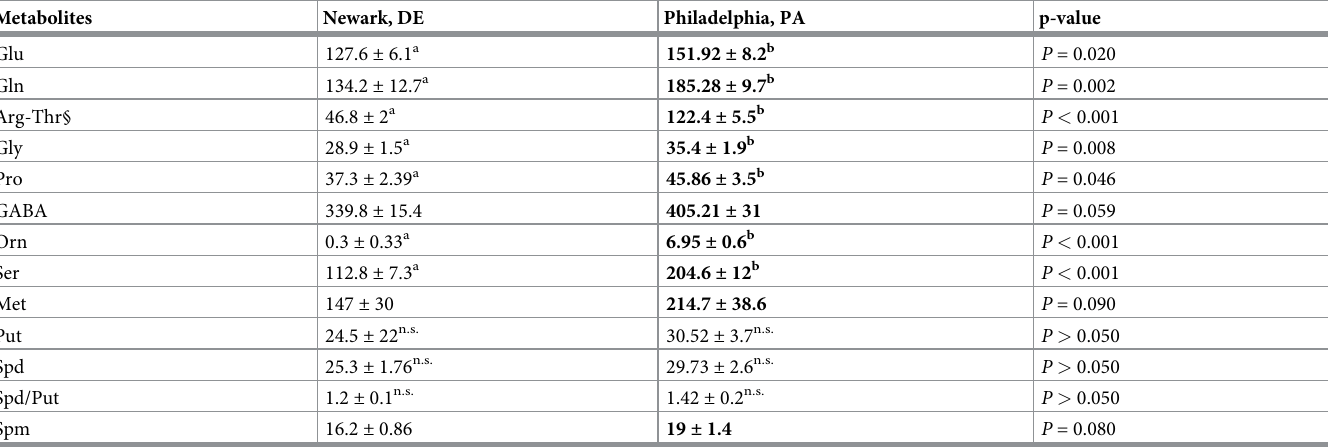
Table 5. Free amino acid and polyamine concentrations (nmol g -1 FW) in the foliage of 76 red maples in ten forests in Newark, DE and Philadelphia, PA.